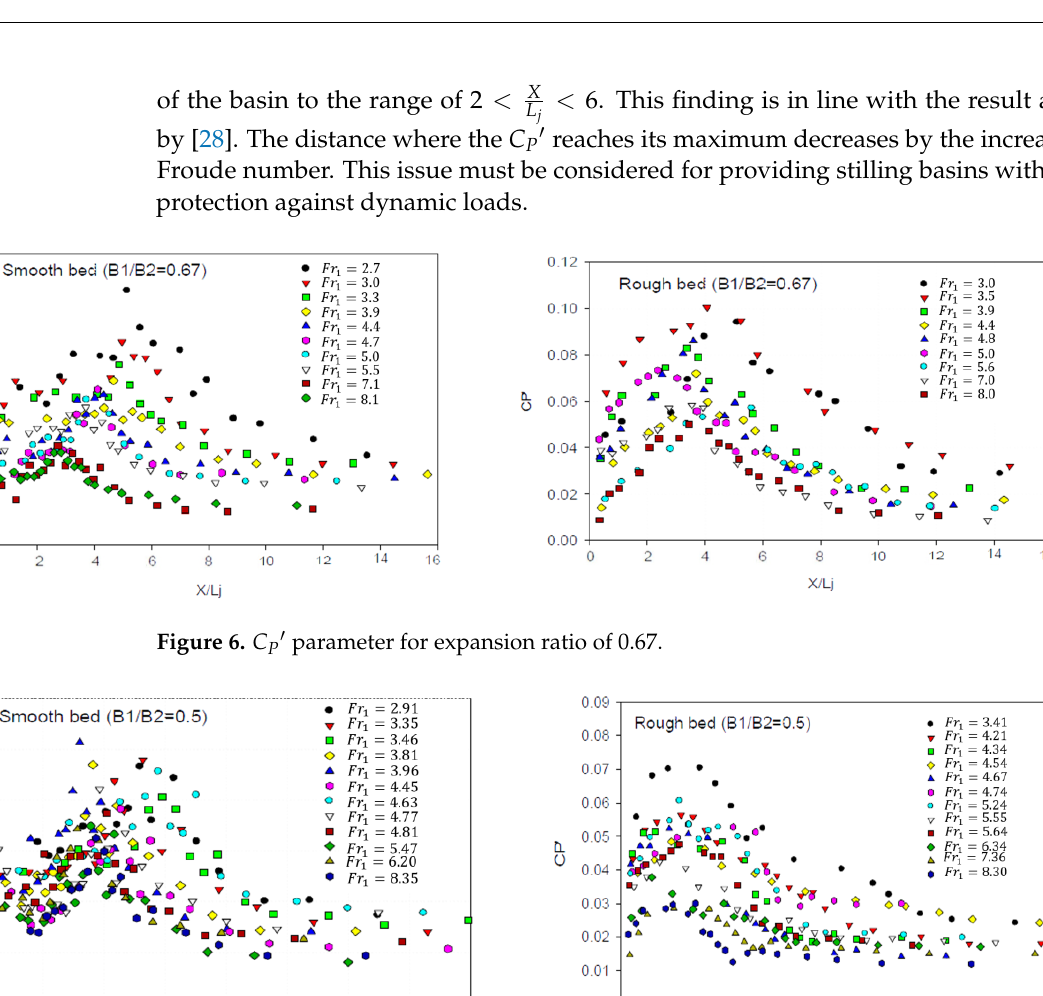
8 of 13 Figure 5. 𝐶 𝑃′ parameter in a prismatic jump. •